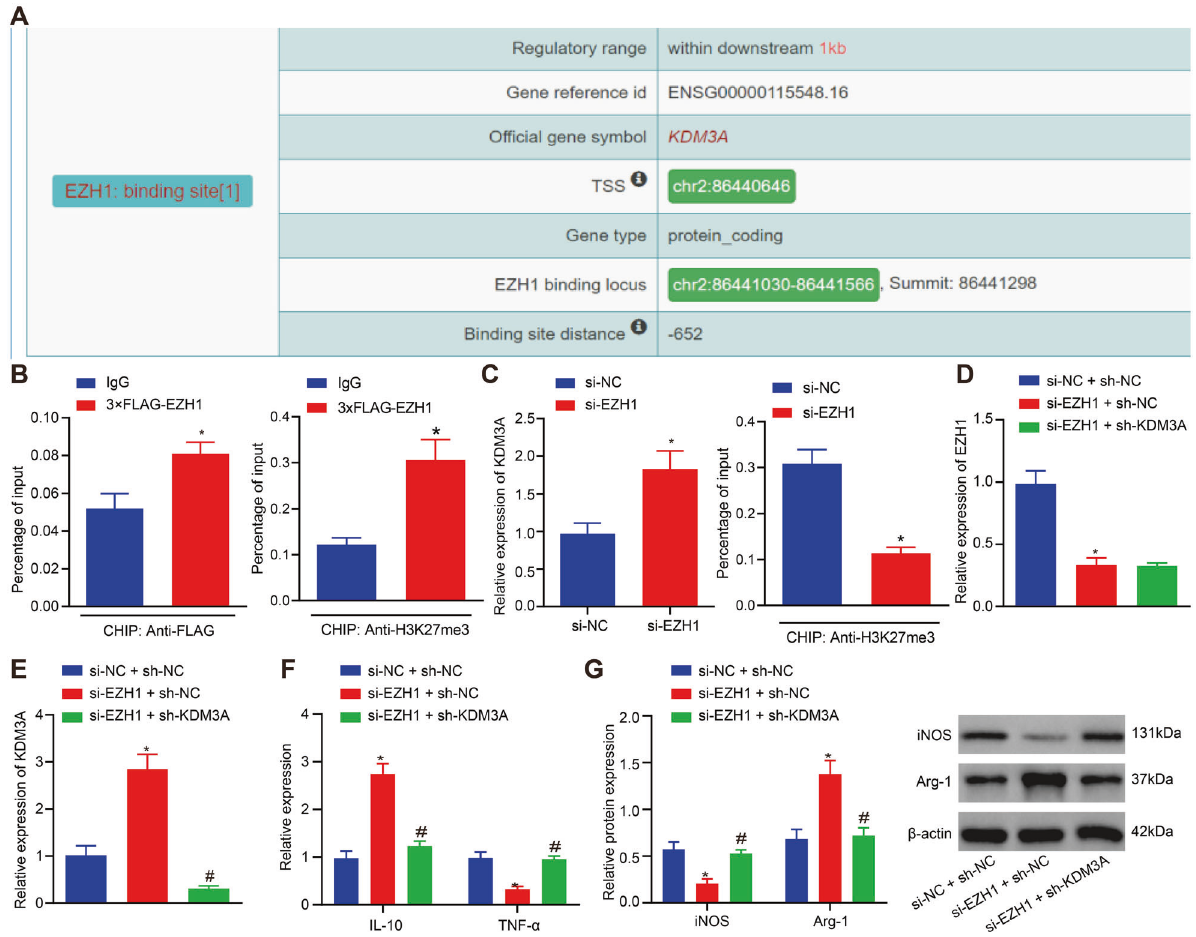
Fig. 4 EZH1 suppresses M2 polarization by downregulating KDM3A . A ChIP-Seq data analysis results of the binding sites. B Enrichment of EZH1 and H3K27me3 on the KDM3A promoter in macrophages detected by ChIP analysis. C KDM3A mRNA expression in macrophages determined by RT-qPCR and H3K27me3 enrichment on the KDM3A promoter in macrophages detected by ChIP analysis. D mRNA expression of EZH1 in macrophages cultured under hypoxic conditions determined by RT-qPCR. E mRNA expression of KDM3A in macrophages cultured under hypoxic conditions determined by RT-qPCR. F mRNA expression of IL-10 and TNF- α in macrophages cultured under hypoxic conditions determined by RT-qPCR. G The expression of iNOS and Arg-1 detected by Western blot analysis. * p < 0.05 compared with IgG, si-NC or si-NC + sh-NC. # p < 0.05 com p ared with si-EZH1 + sh-NC. The experiment was repeated 3 times